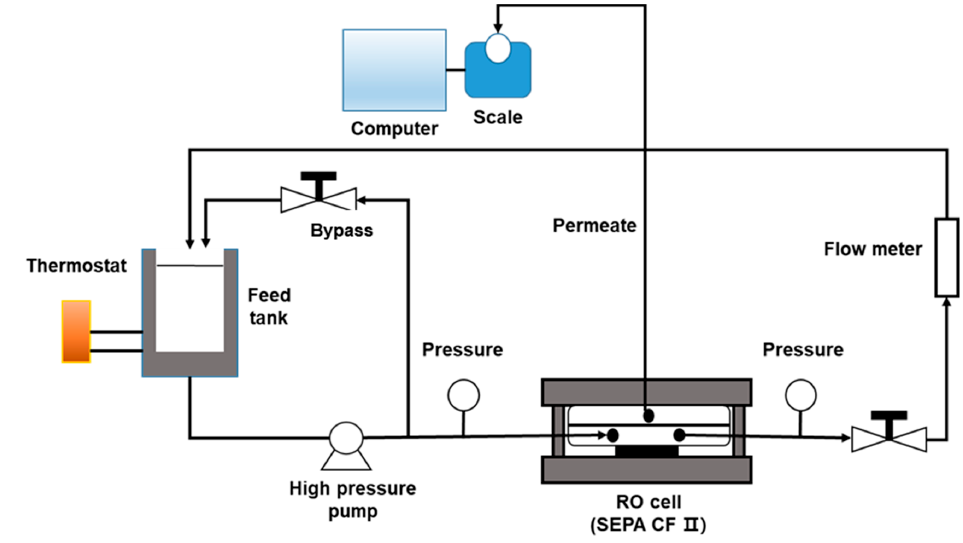
Figure 2. Schematic diagram of a lab-scale reverse osmosis (RO) system. Table 3. List of diluted concentration in pilot studies of the wastewater–seawater (WW-SW) integrated RO process with operating condition and membrane